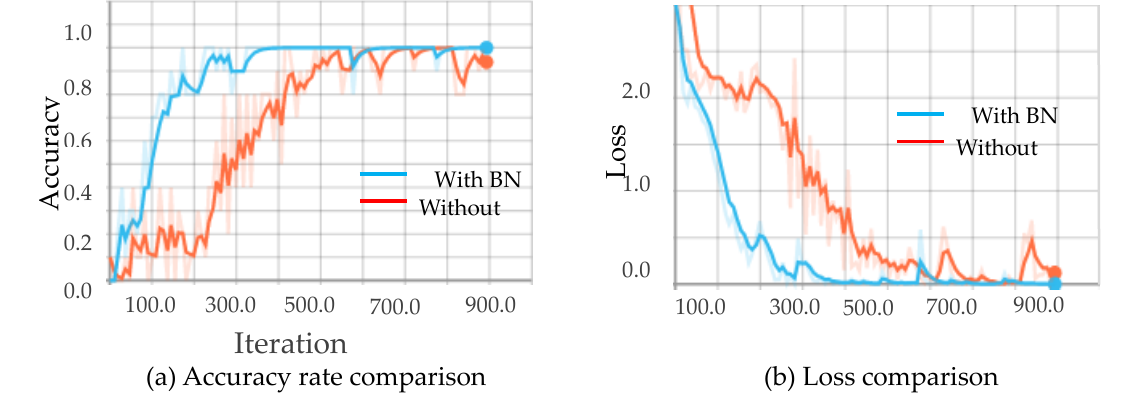
Figure 10. Comparison curves for the RGB image.